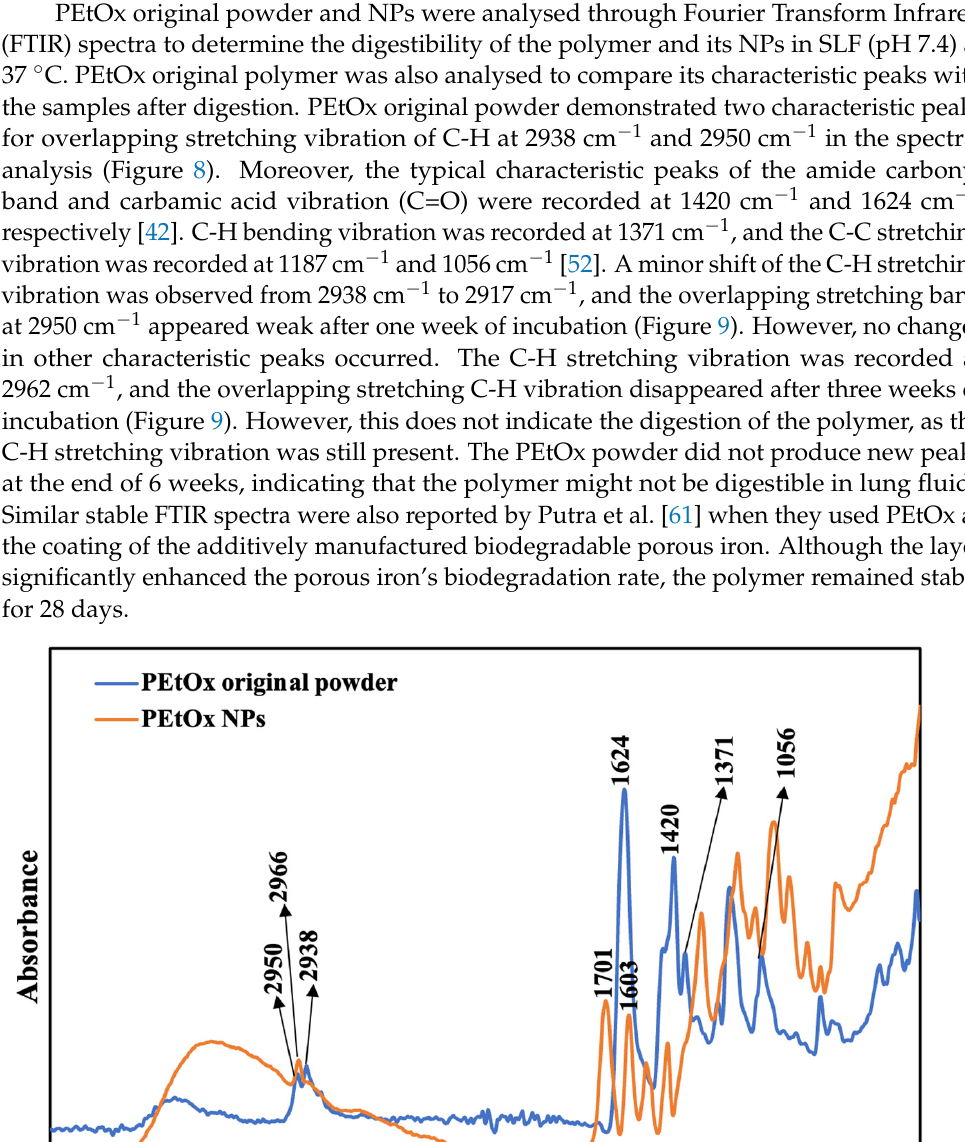
Figure 9. FTIR spectra of PEtOx powder before and after the incubation period of six weeks in SLF. PEtOx NPs also demonstrated a single C-H stretching vibration at 2966 cm − 1 in place of two overlapping stretching vibrations of PEtOx powder. The hydrogen bonding at 1701 cm − 1 disappeared, and a new peak appeared at 1717 cm − 1 after one week of incubation, which is the characteristic peak of TA according to the previous findings (Figure 10) [62]. Thus, the FTIR spectra confirmed that the NPs break down in SLF after one week and return to their original form of TA. Moreover, the newly appeared peaks of the incubated samples at 1717 cm − 1 disappeared after two weeks of incubation (Figure 10). Thus, TA is digestible in lung fluid and safe for pulmonary delivery. Additionally, the carbamic acid vibration (C=O) of PEtOx NPs shifted from 1603 cm − 1 to 1632 cm − 1 , which is very close to